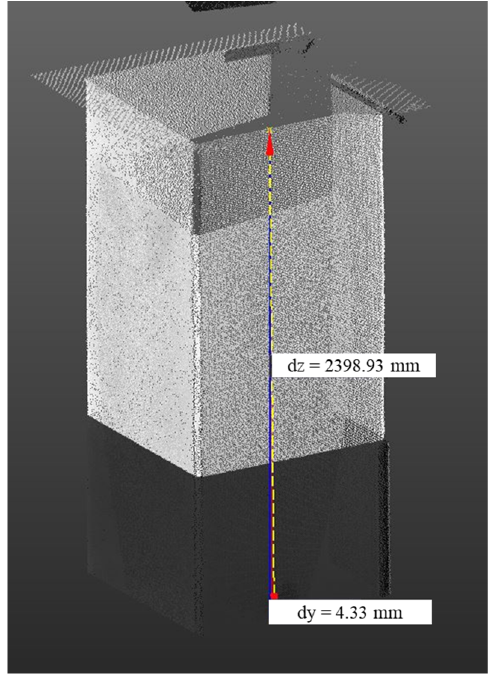
Figure 19. Point cloud data of column for deformation evaluation (the largest value of deformation).